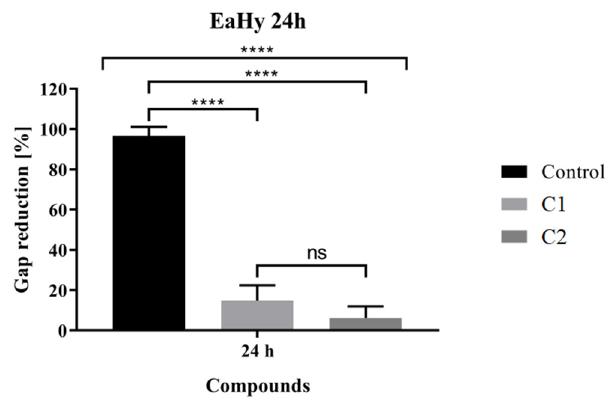
Figure 7. Scratch assay result chart showing percentages of gap reduction after 24 h treatments with IC 20 concentrations of compounds C1 and C2 (**** p < 0.0001).